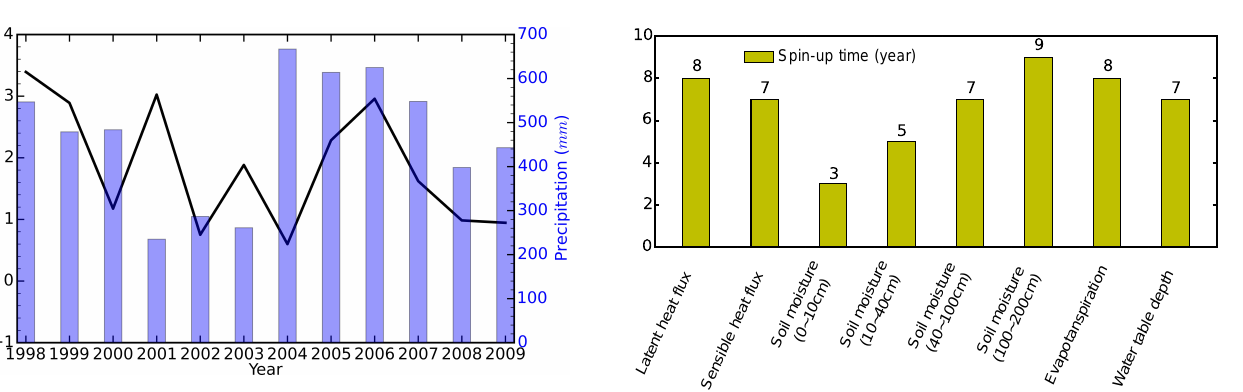
Figure 2. Monthly air temperature above the canopy and precipita- tion at BERMS SK-OAS site.